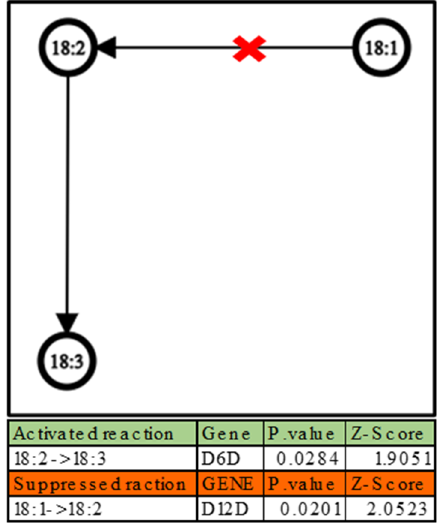
Figure 5. Network graphs depict the interconversion of the building blocks in the PCs’ lipid class in the HbS group compared to the WT. The table below the graph demonstrates the possible activated/suppressed reactions with their p -values and Z-scores and the genes that could be involved in the interconversion.